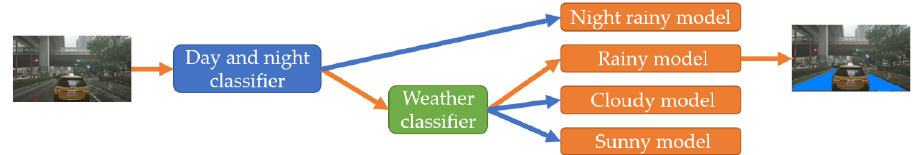
Figure 9. Mechanism of model selection.